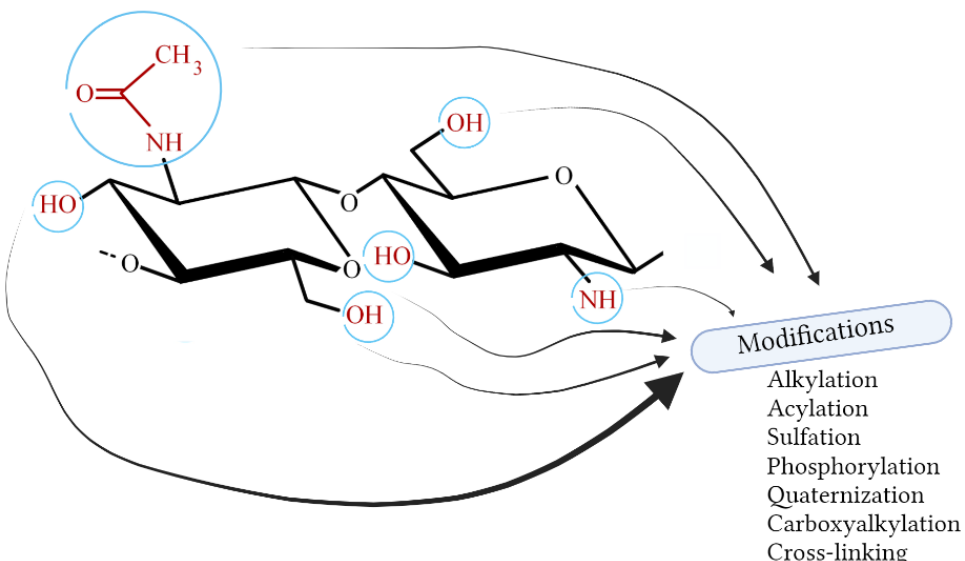
Figure 6. Selected modifications of chitosan (Created with BioRender.com; accessed on 9 February 2023) .